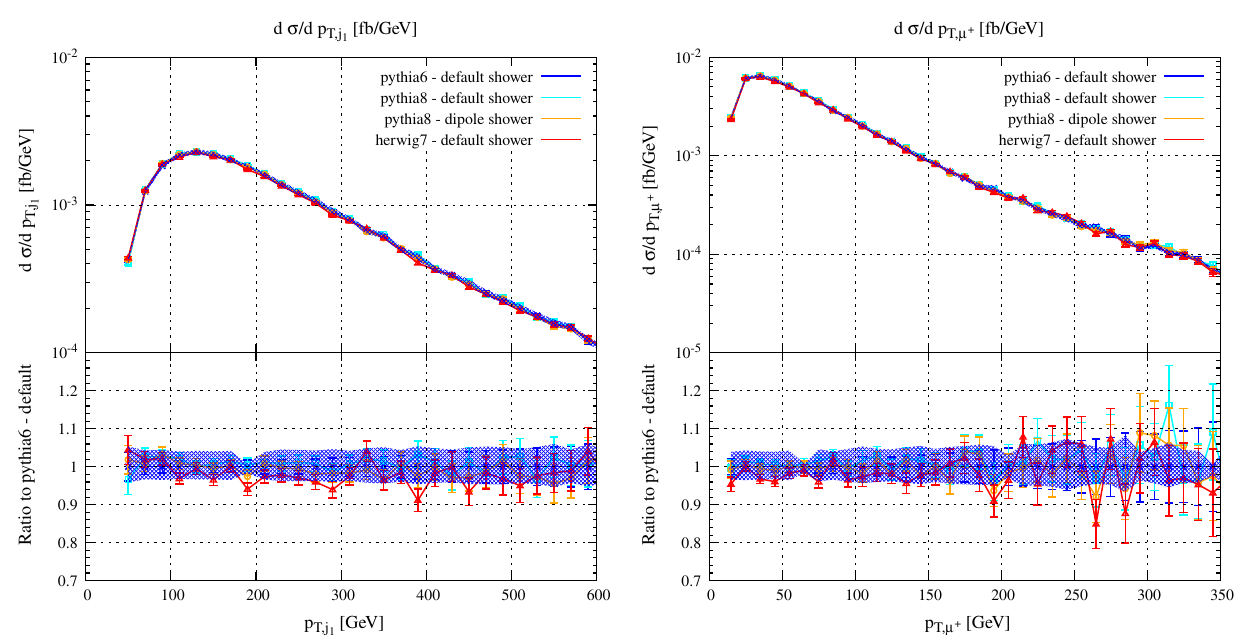
Fig. 6 Transverse-momentum distributions of the hardest tagging jet (left) and of the positively charged muon (right) in the ATLAS-loose scenario. In the lower panels the ratio of the respective distribution to